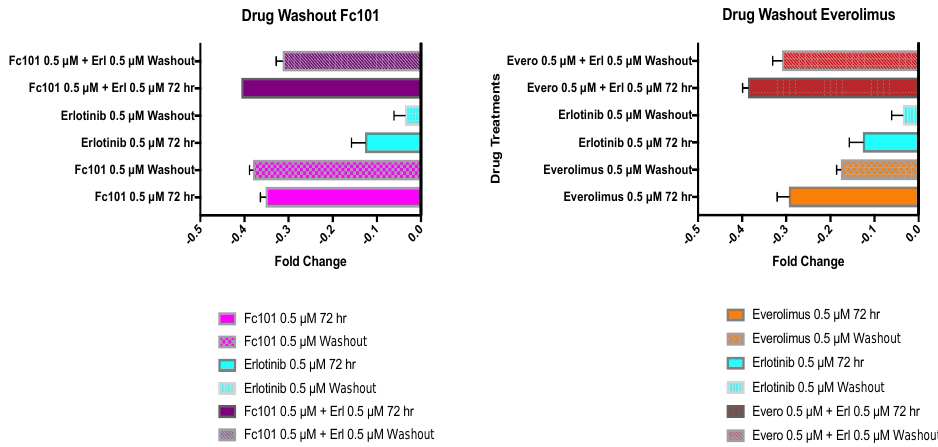
Figure 8. Drug washout assay. Fold changes in viability for the 72 h treatment period are graphed alongside viability fold changes for the 72 h recovery period after drug washout. Solid bars represent 72 h treatment conditions; patterned bars represent the drug washout conditions. Treatment concentrations included FC101 (0.5 μM), erlotinib (0.5 μM), everolimus (0.5 μM), and combinations of FC101 or everolimus with erlotinib.